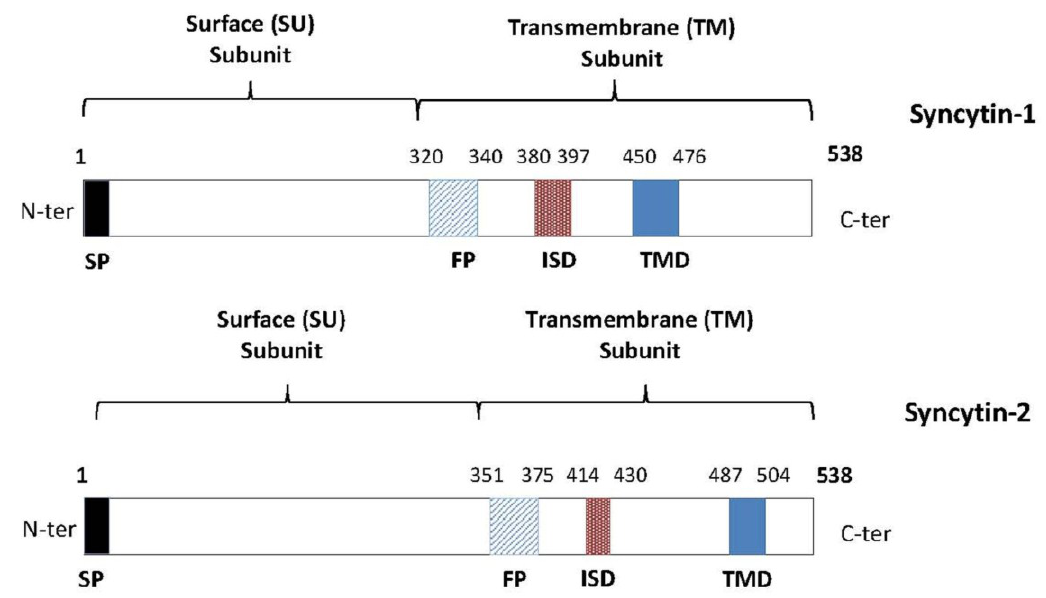
Figure 1. Schematic presentation of the functional domains of Syncytin-1 and -2. Similarly to other retroviral glycoproteins, Syncytin-1 and Syncytin-2 are synthesized as inactive precursors, which are then cleaved into two functional subunits: the SU and the TM subunit. SU is responsible for receptor binding and TM mediates the fusion. Both proteins are 538 amino acids long and harbor a fusion peptide (FP), a functional immunosuppressive domain (ISD) and a transmembrane domain (TMD) in their TM subunit. As a membrane protein, the polyprotein also possesses a cleaved signal peptide (SP) at its amino